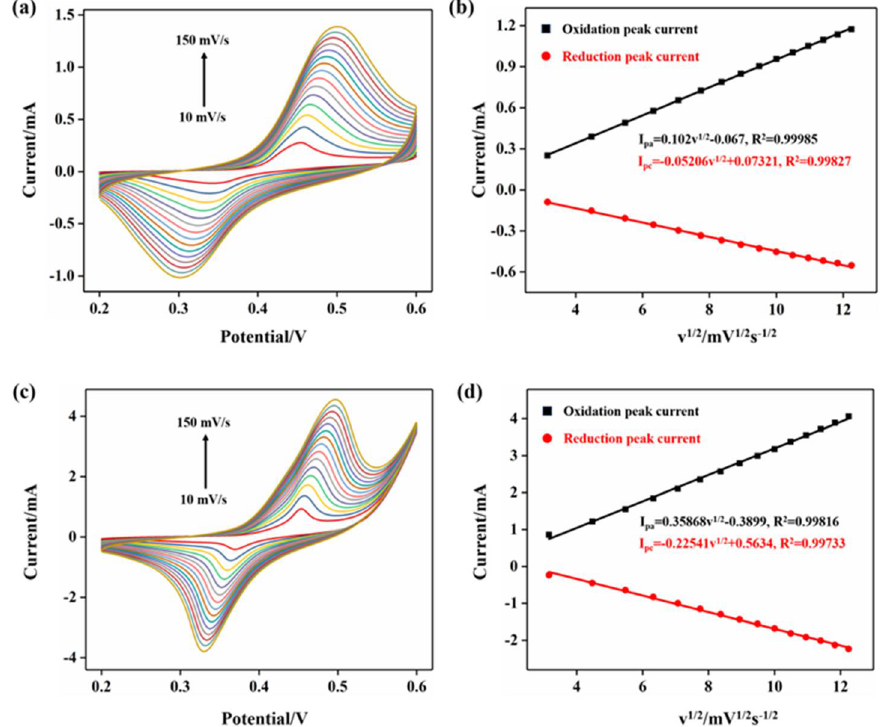
Figure 6. The CV curves of the Ni − TNT electrode ( a , b ) and ( c , d ) the Ni − DLC/TNT composite electrode at a scanning rate of 10 − 150 mV/s, the linear fitting graphs of the corresponding anode (I pa ) and cathode oxidation peak current (I pc ), and the square root of the scanning rate v 1/2 . TNT electrodes have no catalytic activity.